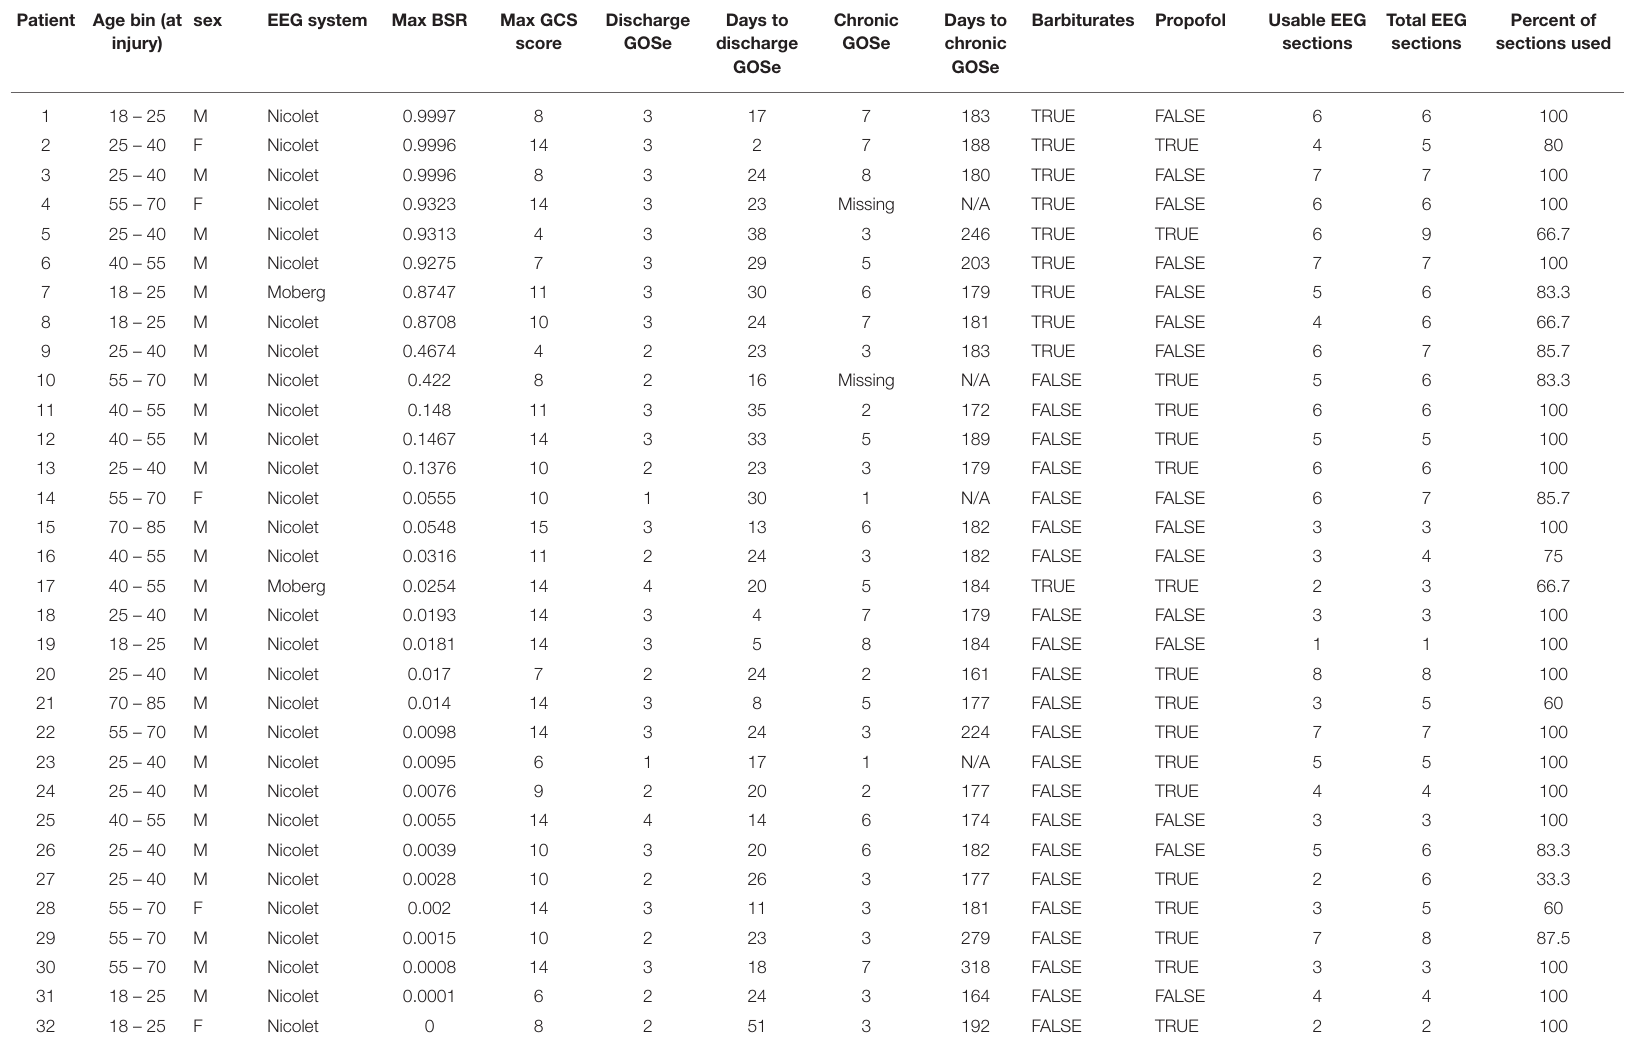
TABLE 1 | Patients demographics, assessment scores, and medications. Patient Age bin (at